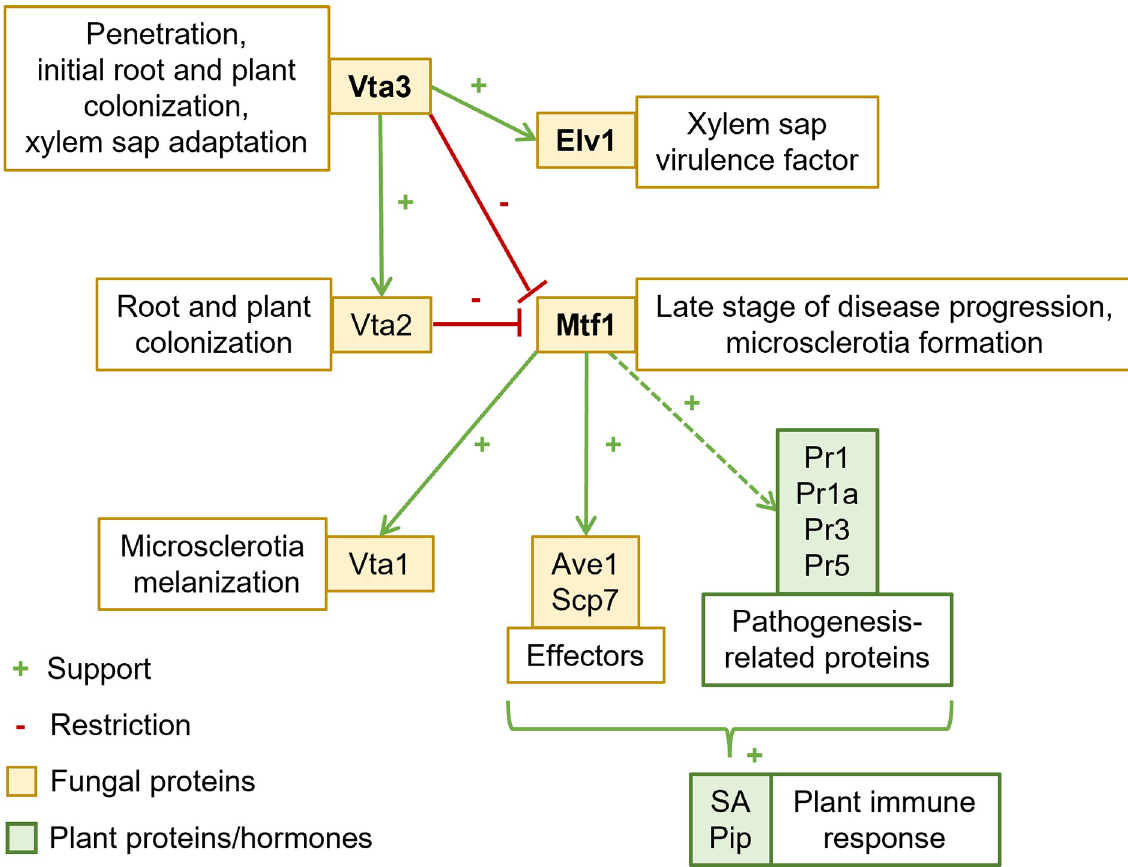
Fig 11. Model of cellular functions and control of the Verticillium dahliae Vta-Mtf1 network in microsclerotia formation, plant colonization and immune response. Expression of the transcription factor Mtf1-encoding gene is induced in the absence of the transcriptional regulators Vta3 and Vta2. Vta3 induces VTA2 expression [17]. Expression of the xylem sap virulence factor Elv1-encoding gene is induced in the presence of VTA3 . Mtf1 promotes microsclerotia formation and the expression of VTA1 to favor melanization. Expression of pathogenesis-related protein (PR) genes and levels of phytohormones such as salicylic acid (SA) and pipecolic acid (Pip) in tomato plants are increased in the presence of MTF1 , supporting plant disease and immune responses. Expression of AVE1 and SCP7 , encoding V . dahliae effectors, is elevated in the presence of MTF1